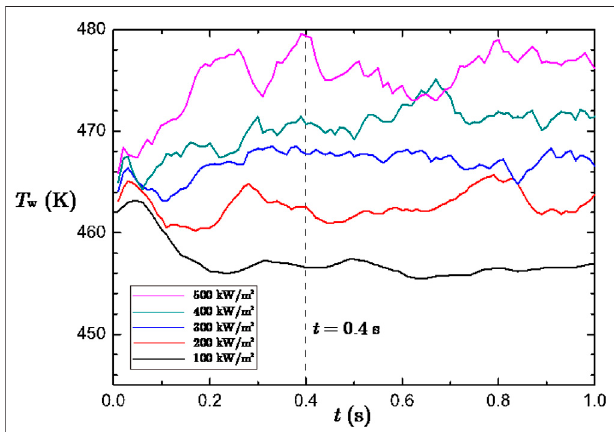
FIGURE 9 | Spatial average wall temperature under various wall heat fl